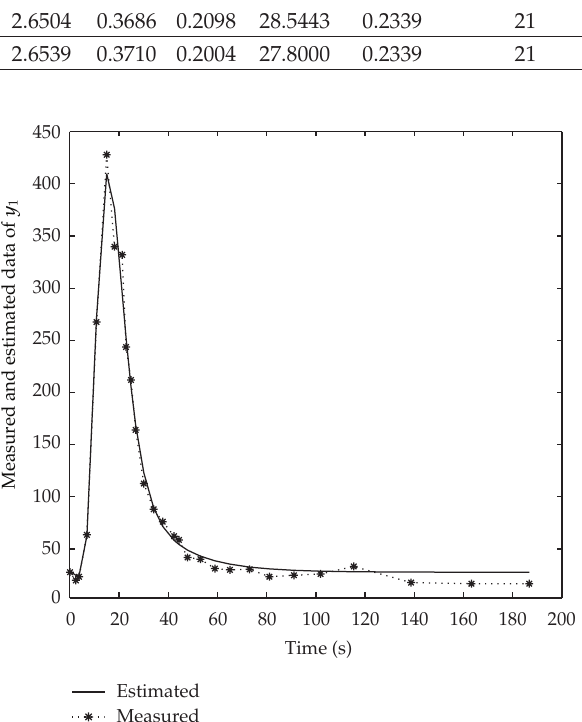
Figure 4: The plots of the estimated and measured data of y 1 in Case 1 (cid:3) 149 iterations (cid:4)